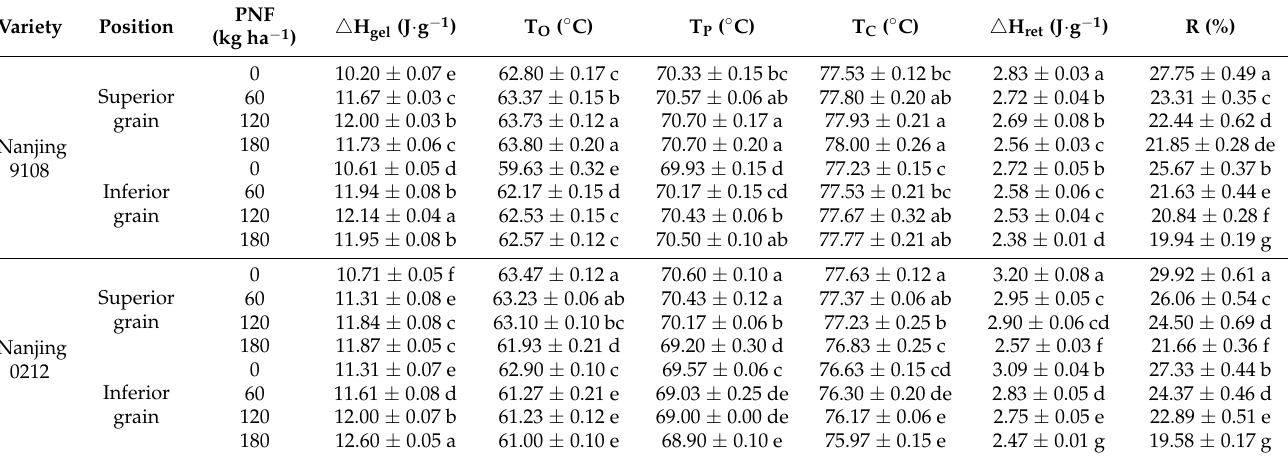
Table 6. Starch thermal properties of superior and inferior grains of japonica rice under different PNF